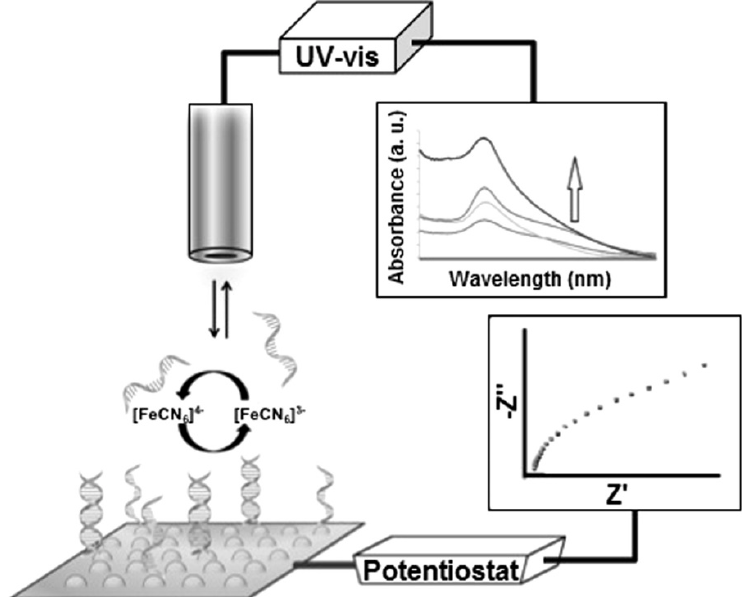
Figure 8. Illustration of the DNA sensor with dual-detection platform for localized surface plasmon resonance (LSPR) and electrochemical impedance spectroscopy (EIS) measurements (Reproduced with permission from [85]. Elsevier, 2014).